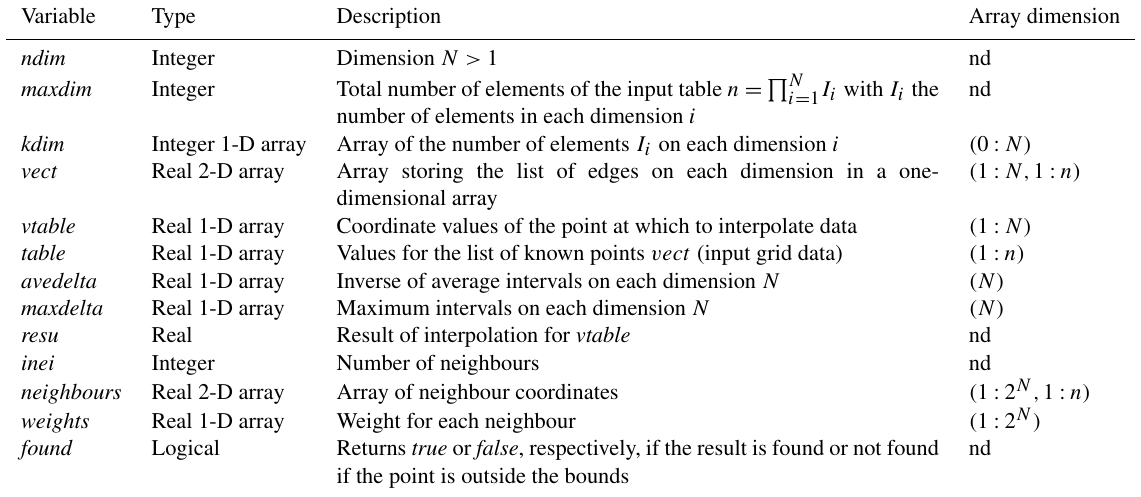
Table C1. Description of subroutine arguments.